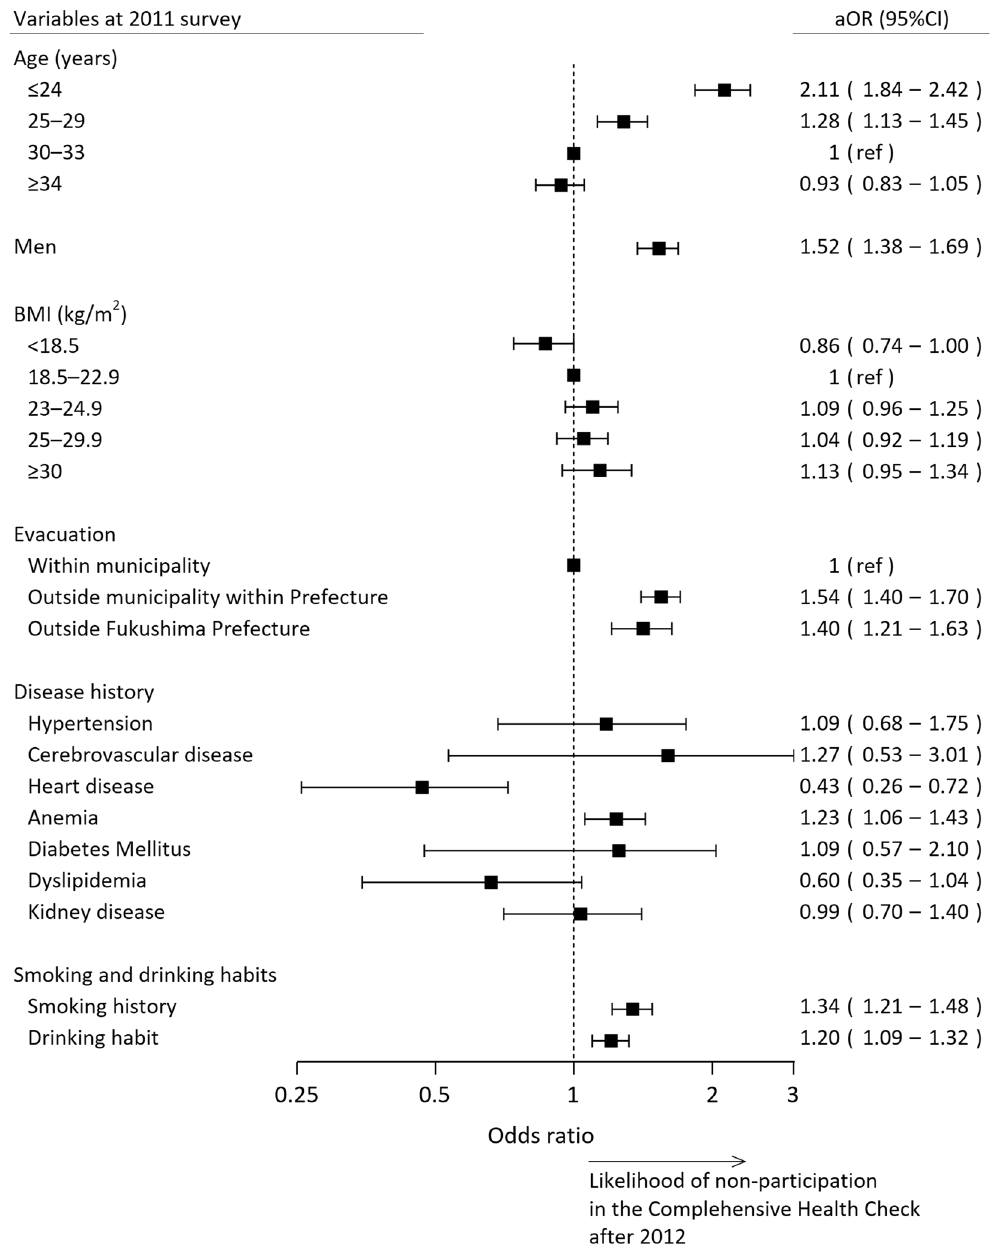
Figure 2. Multivariate analysis to predict non-participation in the Comprehensive Health Check in the Fukushima Health Management Survey. A forest plot of the likelihood of non-participation in the Comprehensive Health Check after 2012 is shown. The higher odds indicate a higher likelihood of non- participation after the second survey. aOR adjusted odds ratio, BMI body mass index, CI confidence